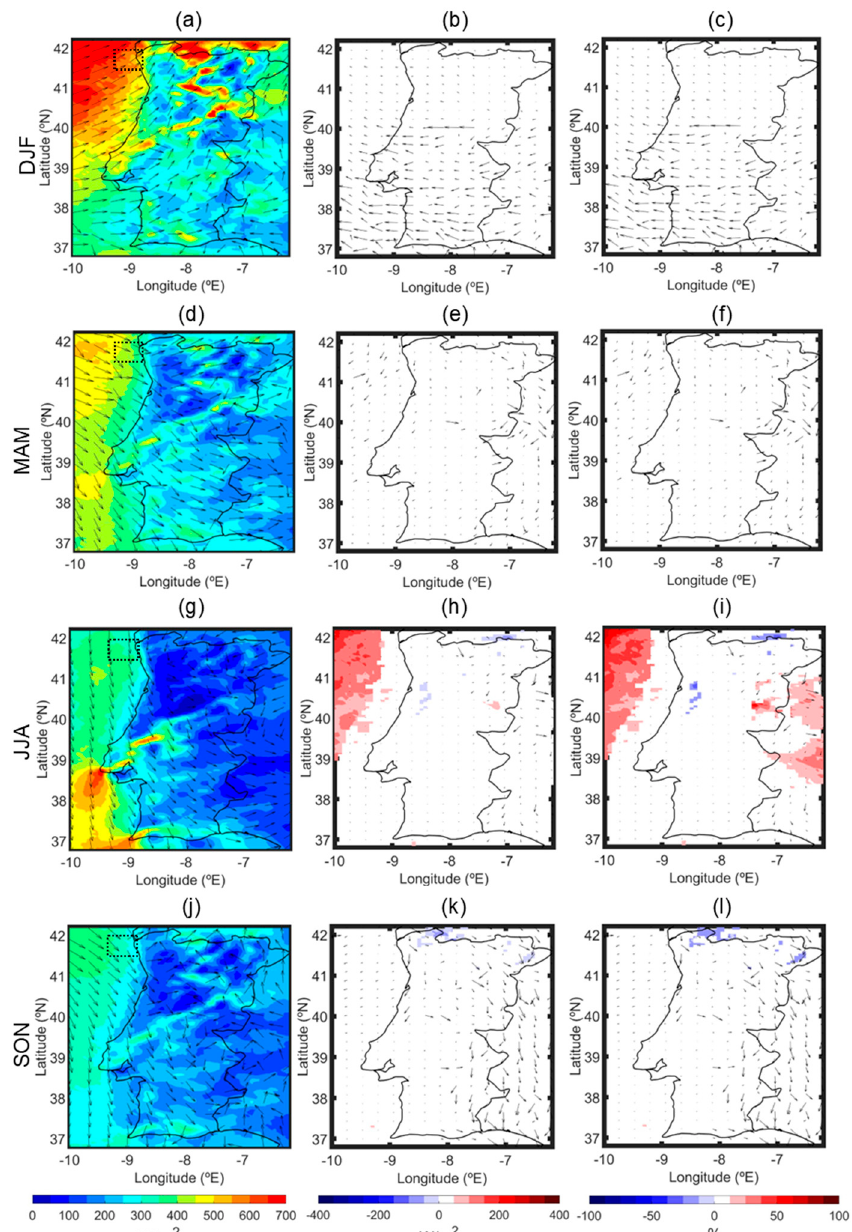
Figure 6. Seasonal (winter: DJF, spring: MAM, summer: JJA, and autumn: SON) median of 100 m WPD for 1995–2014 (left column ( a , d , g , j ), in W/m 2 ), and corresponding absolute (middle column ( b , e , h , k ), in W/m 2 ) and relative (right column ( c , f , i , l ), in %) anomalies for 2046–2065, under SSP5-8.5. Black arrows correspond to the respective seasonal median wind direction (1995–2014, left column) and wind direction anomaly (2046–2065, middle and right columns).